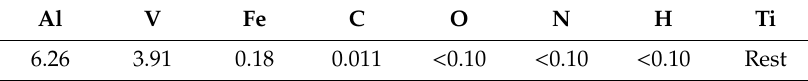
Table 1. Experimental Ti6Al4V substrate composition (wt %).